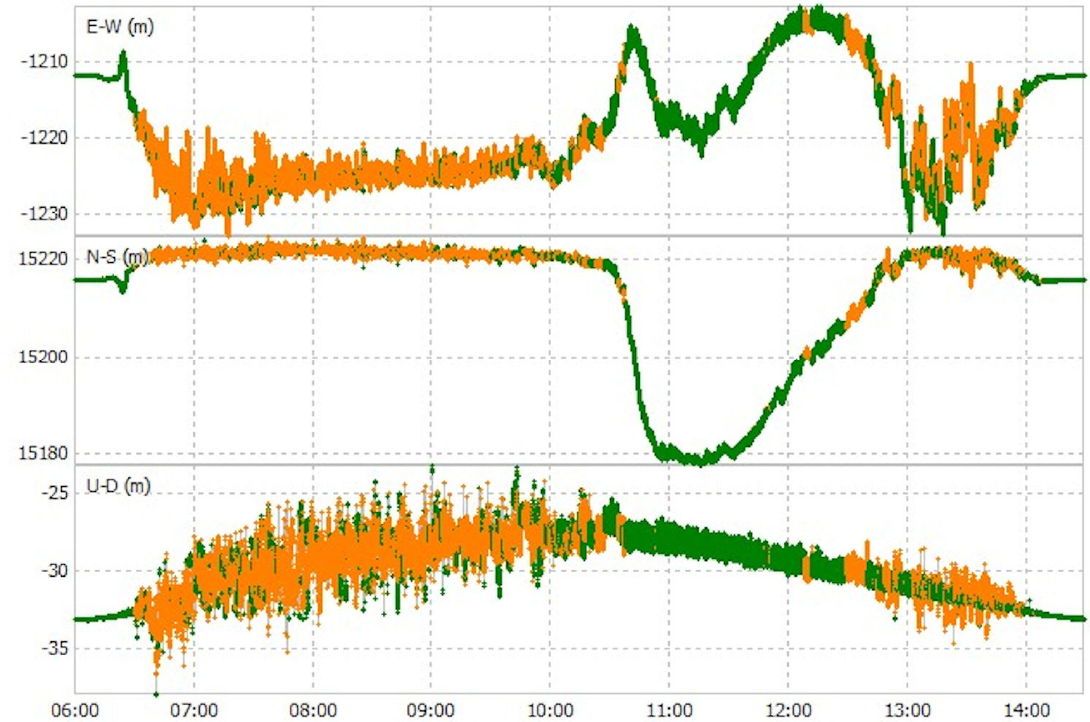
Figure 6. Buoy positional components during tidal cycle B; East–West (E-W), North–South (N-S) and Up–Down (U-D), August 29 2019 06:00–14:00. Fixed solutions (Q1) are shown in green, and float solutions (Q2) are shown in